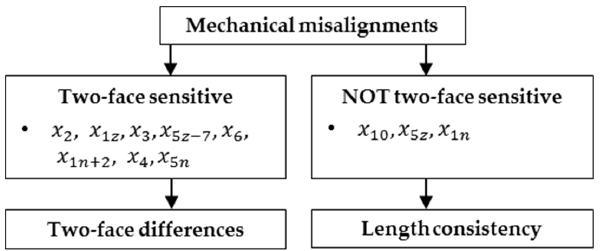
Figure 6. Calibration parameter division and overview of their two-face sensitivity based on their functional connection with the TLS measurements ( 𝑟 𝜑 , 𝜃 ). functional connection with the TLS measurements ( r , ϕ , θ